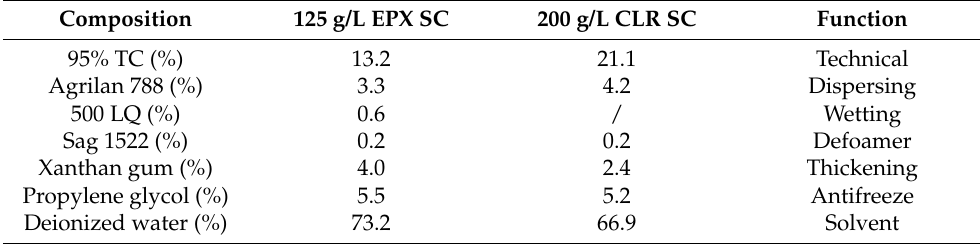
Table 1. EPX and CLR SC